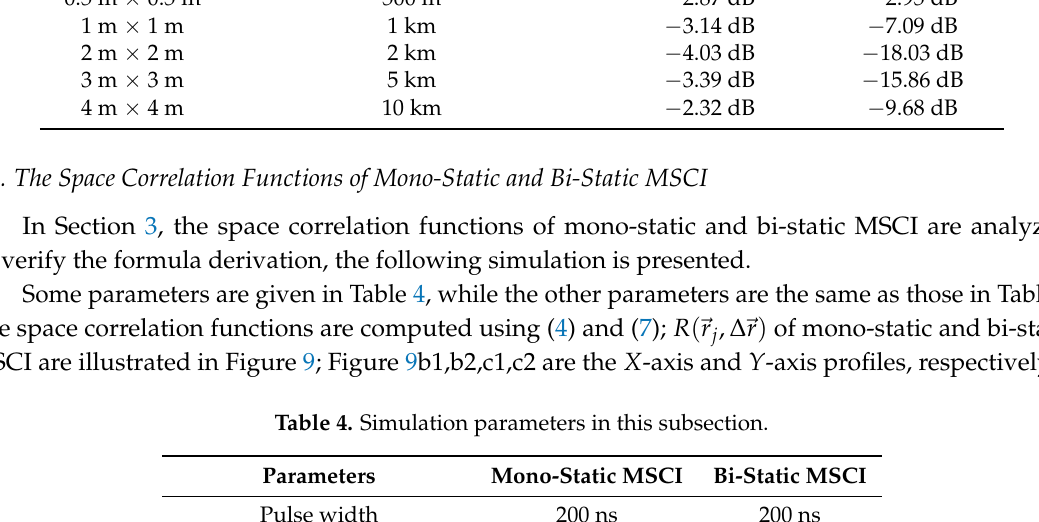
Table 3. The normalized mean square error (NSME) of the reconstructed images. Grid Cells Size The Height of the Radar Platform